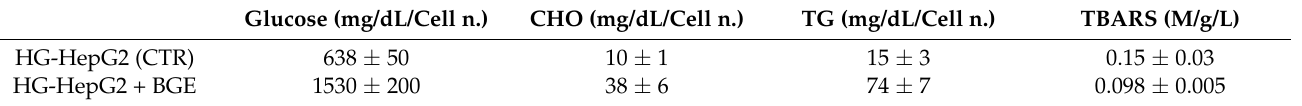
Table 2. Glucose, cholesterol (CHO), and triglycerides (TG) concentration in the culture medium of HG-HepG2 cells treated for 72 h with 1.0 mg/mL BGE compared to untreated control cells (CTR). The TBARS were evaluated in HG-HepG2 cells after 72 h of 1.0 mg/mL BGE treatment. Glucose (mg/dL/Cell n.) CHO (mg/dL/Cell n.) TG (mg/dL/Cell n.) TBARS (M/g/L) HG-HepG2 (CTR) 638 ± 50 10 ± 1 15 ± 3 0.15 ± 0.03 HG-HepG2 + BGE 1530 ± 200 38 ± 6 74 ± 7 0.098 ±